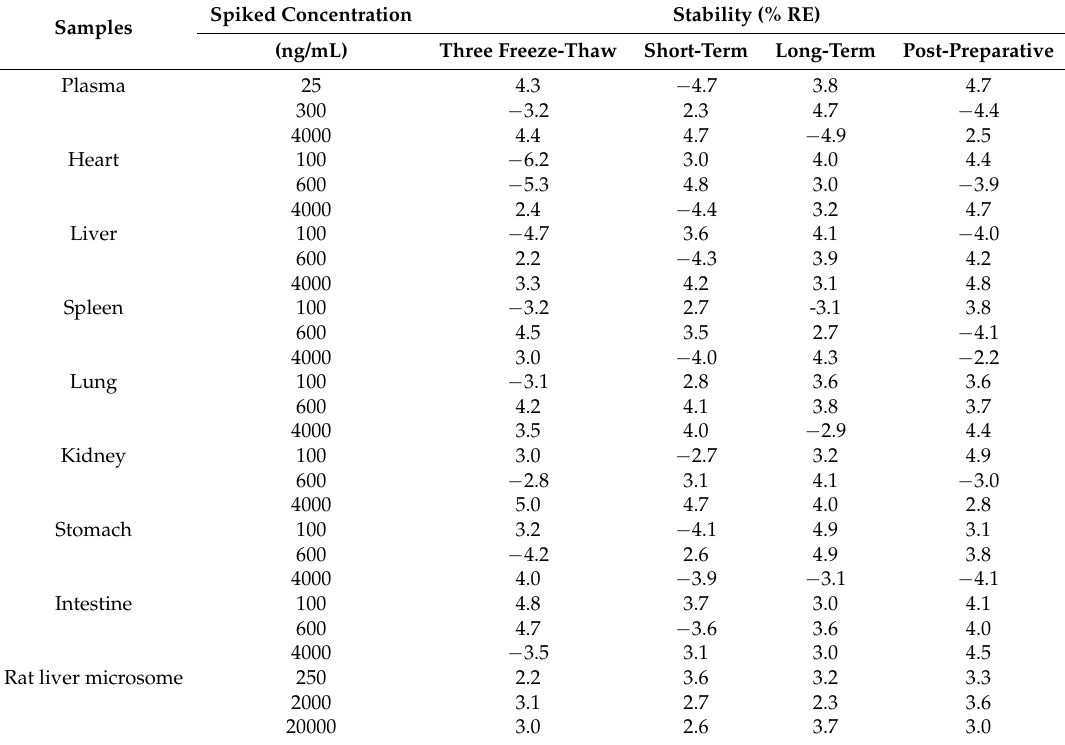
Table 4. Stability data of the analytes in rat biological samples under different conditions (n =